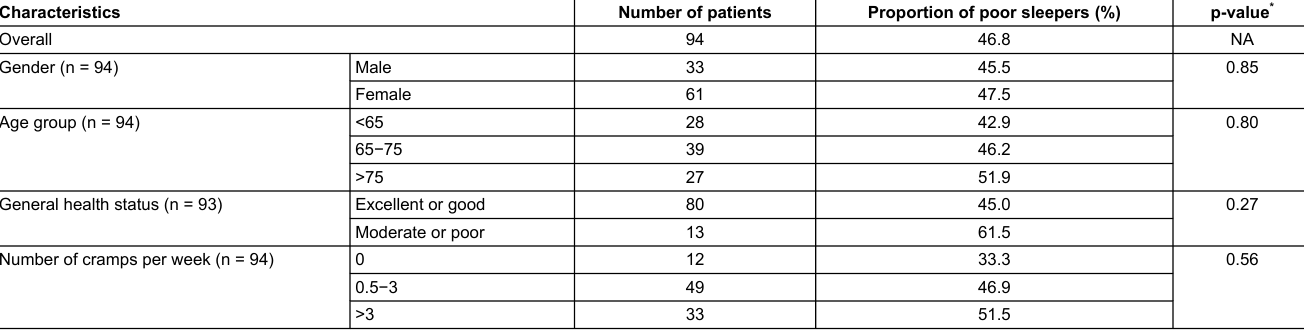
Table 3: Proportion of poor sleepers, overall and stratified by patient characteristics.